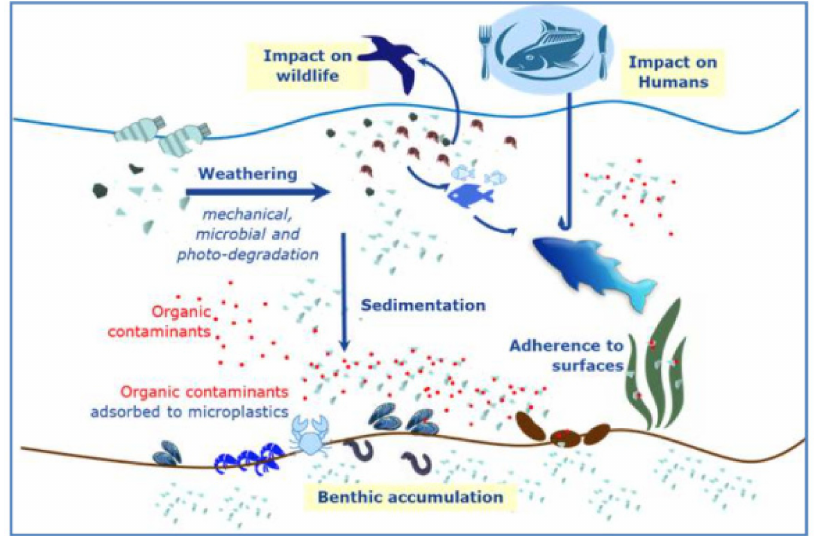
Figure 1. The fate of MPs in the oceans and the impact on living organisms. Source: European Commission. Microplastics: Focus on Food and